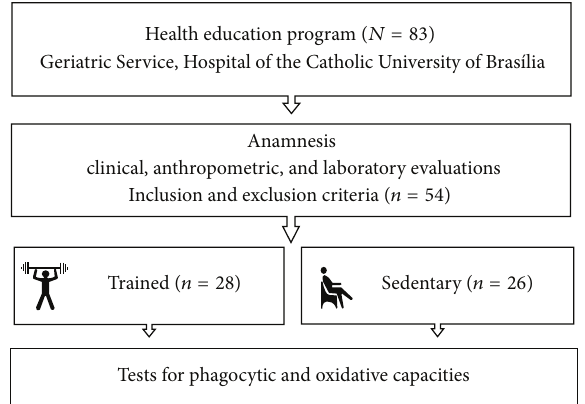
Figure 1: Procedures for sample selection and data